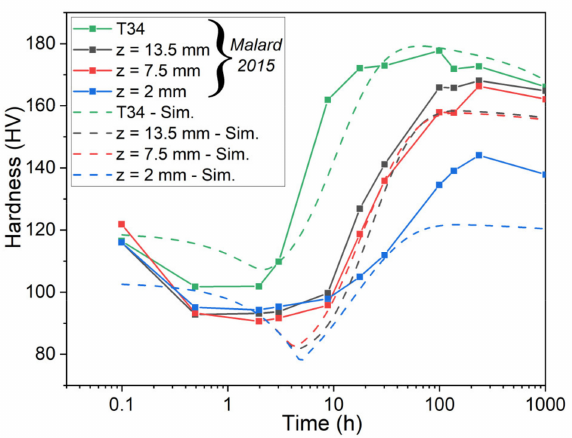
Figure 15. The experimental and simulated normalized hardness evolutions in the nugget at the weld center during post-weld heat treatment at 155 ◦ C. The revised model is used for the simulations. Experimental data comes from Malard et al.